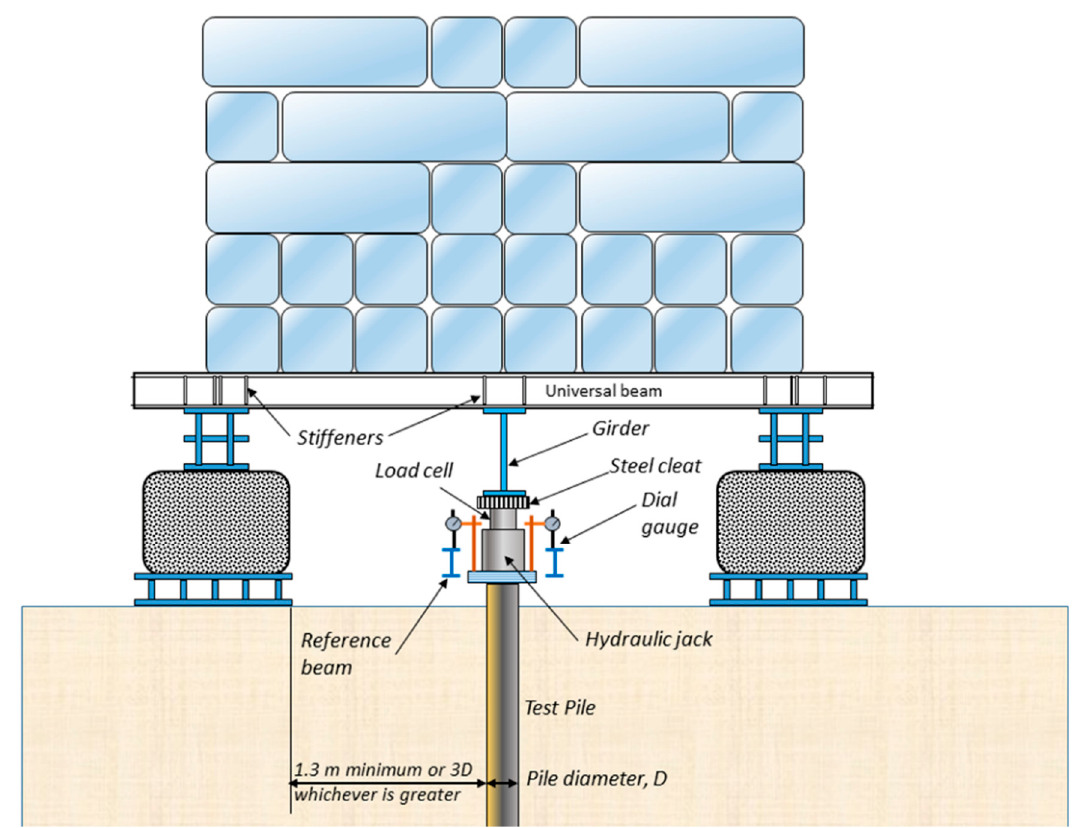
Figure 2. Schematic view of the maintained load test (MLT)